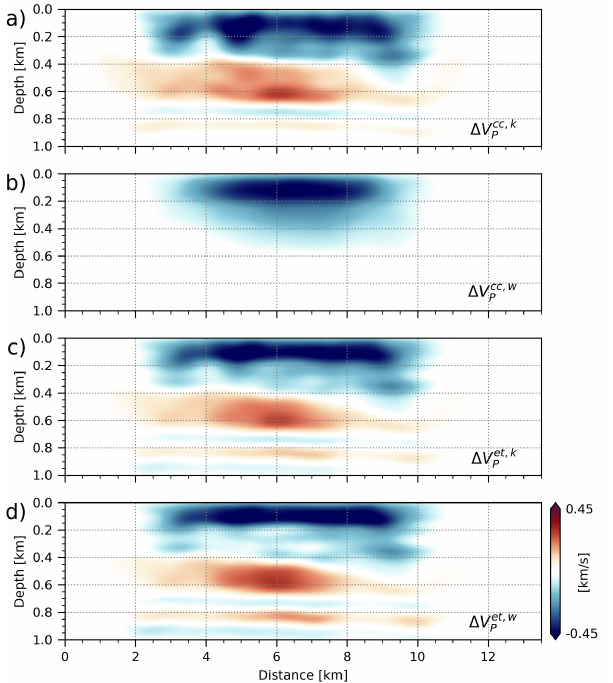
Figure 14. ( a , b ) show the inverted model perturbations ∆ V cc , k and ∆ V cc , w by the traditional CC P P objective function with the correct Klauder wavelet and wrong source wavelet; ( c , d ) are the inverted model perturbations ∆ V et , k and ∆ V et , w by the ET objective function with the correct Klauder wavelet P P and wrong source